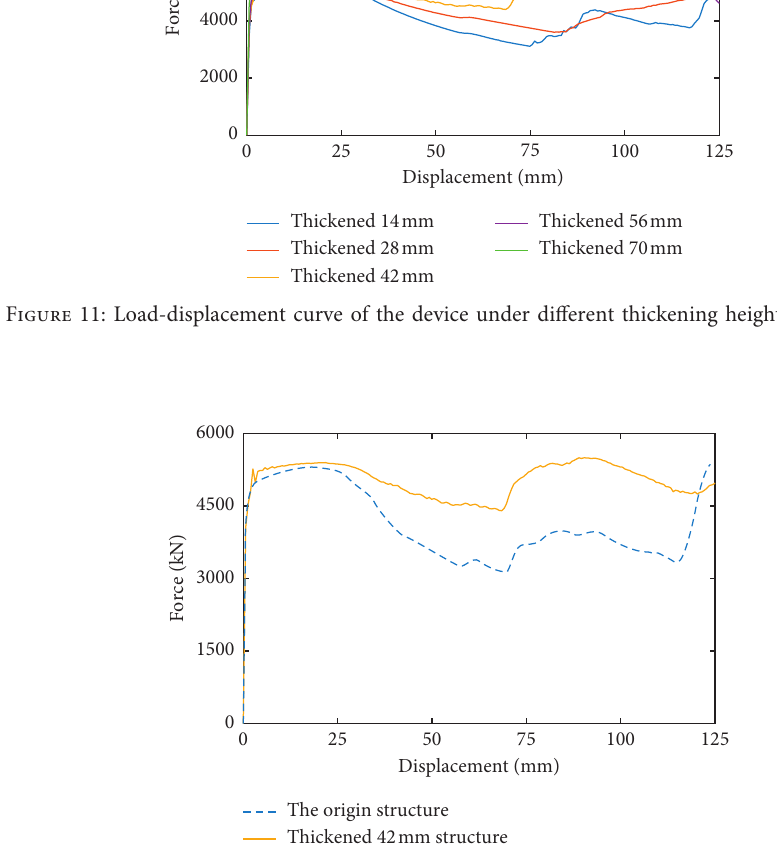
Figure 12: Comparison of the load-displacement curve between the structure with a thickness of 42mm and the original